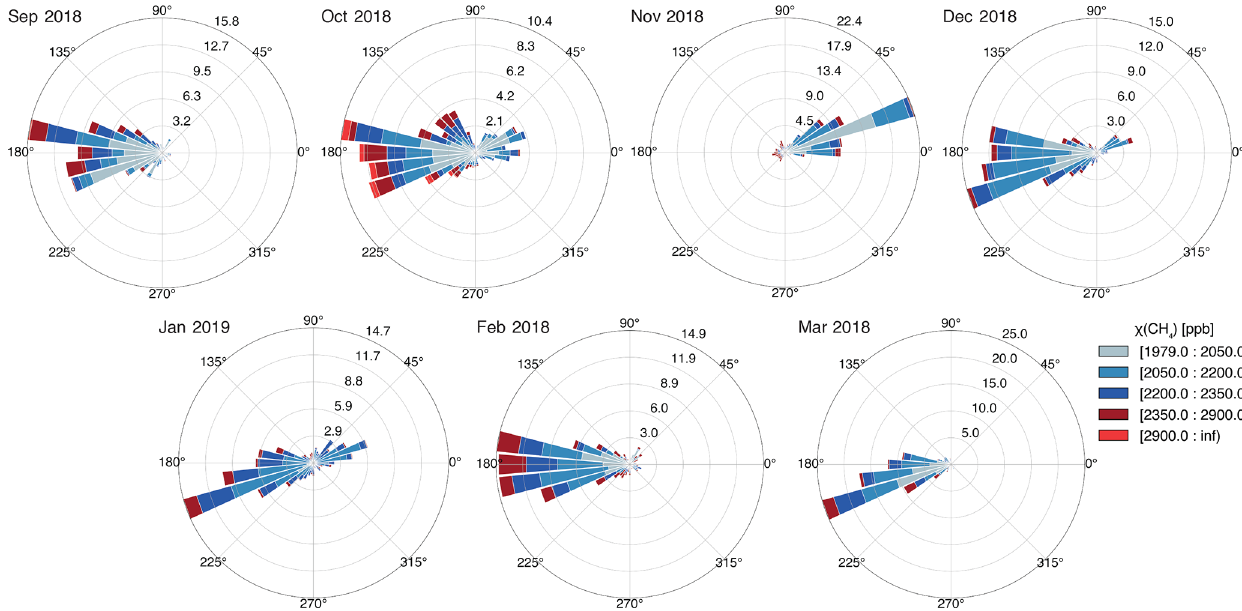
Figure 3. Monthly wind directions during the ambient air measurement period, at the same location. Bar lengths are percentages of records during the specified month ( r axis); colours define the χ (CH 4 ) range